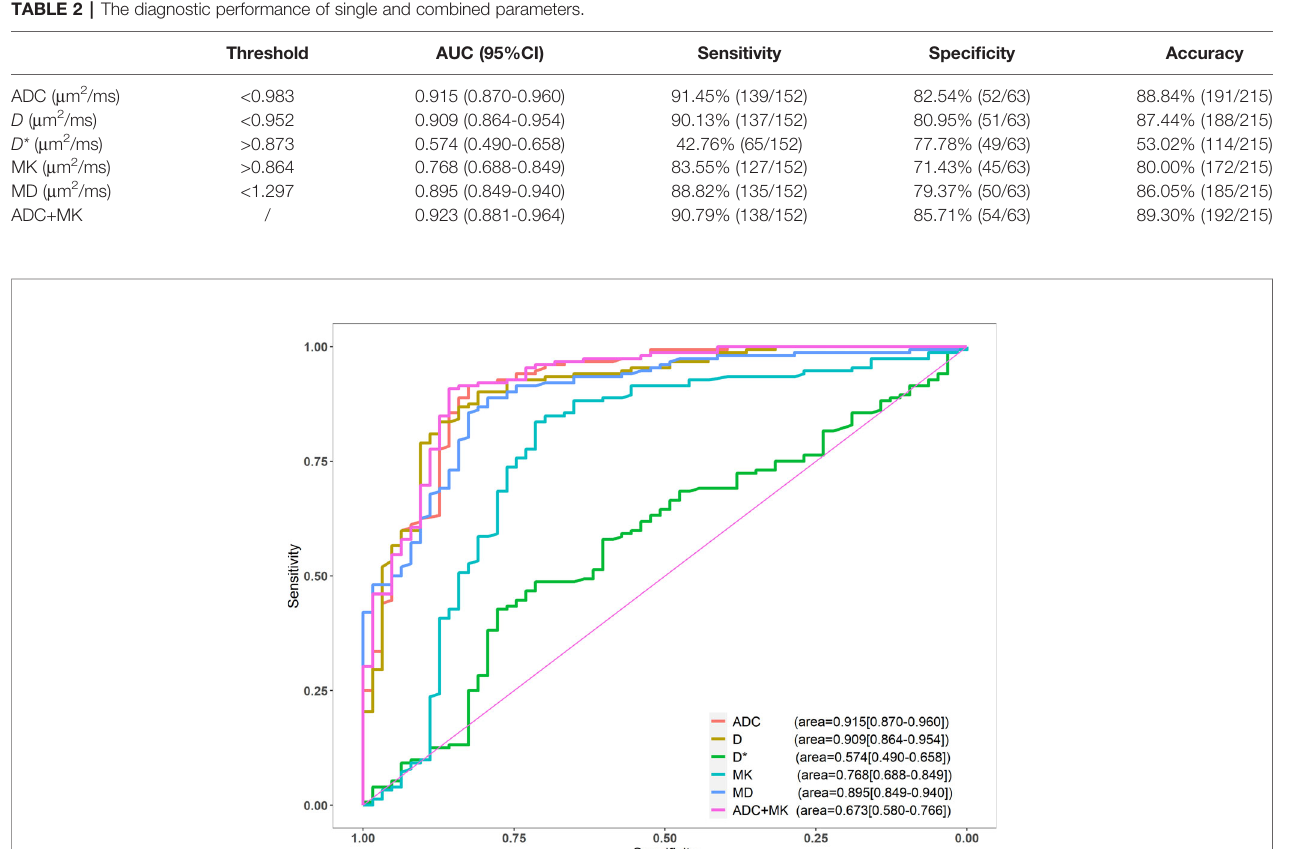
FIGURE 3 | ROC curves of ADC, D , D* , MK, and